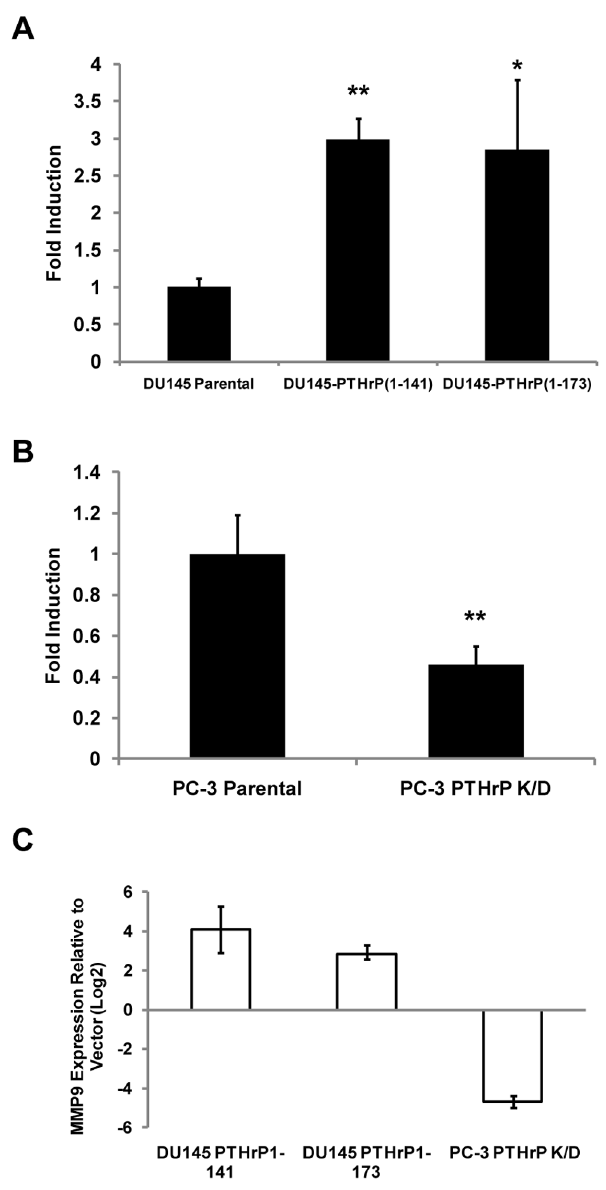
Figure 3. PTHrP Promotes Invasion and MMP-9 Expression. A) Matrigel invasion assay showing increase in invasion of DU145 cells upon overexpression of either PTHrP 1–141 or 1–173. B) Matrigel invasion assay showing decrease in invasion of PC3 cells upon knockdown of PTHrP. C) mRNA levels of MMP-9 in PTHrP-overexpress- ing DU145 cells and PTHrP-knockdown PC3 cells relative to their respective controls. * indicates p , .05, ** indicates p , .01.